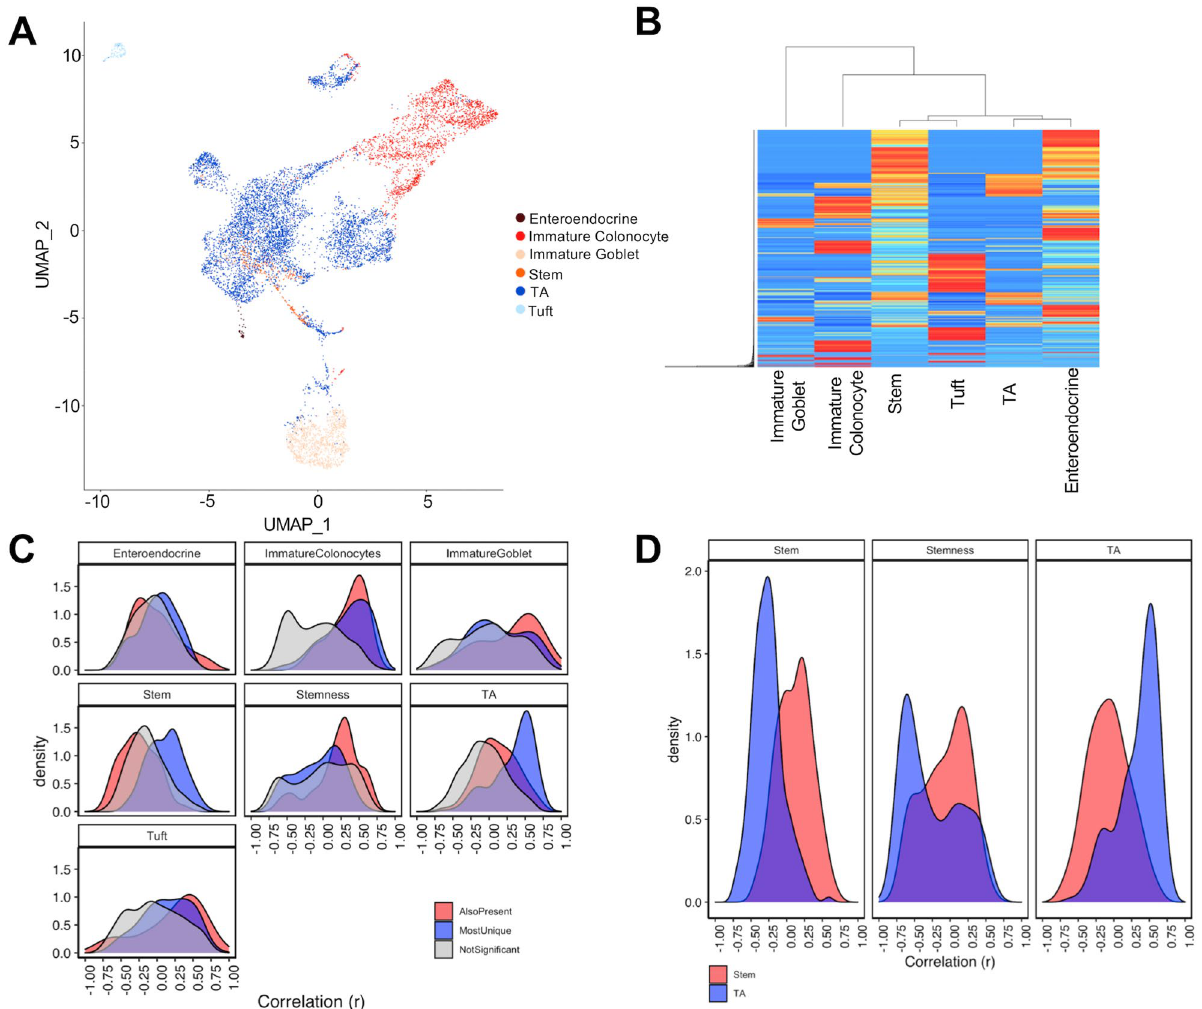
Figure 2. Cell composition analysis in ethanol treated colon organoids. ( A ) Uniform Manifold Approximation and Projection plot of 9659 single cells included in the analysis. ( B ) Heatmap of average gene expression of each gene present in the cell signature matrix. ( C ) Cell scores generated from Cibersortx were correlated to gene markers that were: most unique to that cell-type (blue); significant in that cell type (red); not significant in that cell type (grey). For comparison stemness index scores were compared to stem cell markers. ( D ) Markers of stem cells and TA cells were correlated to Cibersortx cell scores and the stemness index. A separation of markers for TA and stem cells may act as an indicator for performance of cell score in defining these cell-types.